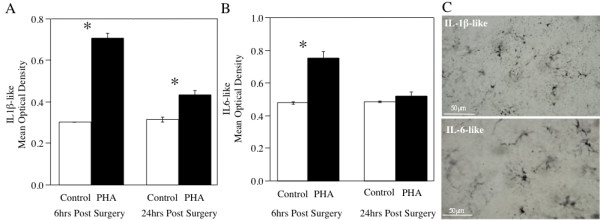
Bar graph depicting the mean uncalibrated optical density (OD) for IL-1β-like (A) and IL-6-like (B) immunoreactive cells at 6 h and 24 h following treatment with PHA. (C) Representative sections depicting the localization of IL-1-like (top) and IL-6-like -ir cells (bottom) following PHA treatment. * denotes a significant difference between treatment and saline.